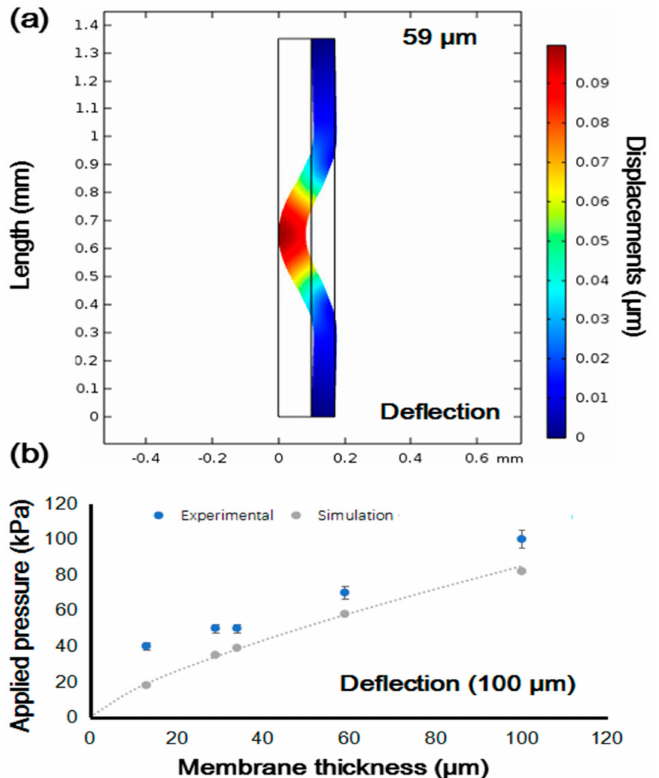
Figure 4. Simulation results of required closing pressure for deflection of membrane in different thickness. ( a ) Deflection of membrane with 59- µ m thickness. Simulation used the pressure applied to the membrane to close the channel and make the velocity to 0 m/s. ( b ) Correlation between membrane thickness and applied pressure, and correlation between simulated closing pressure and experimental